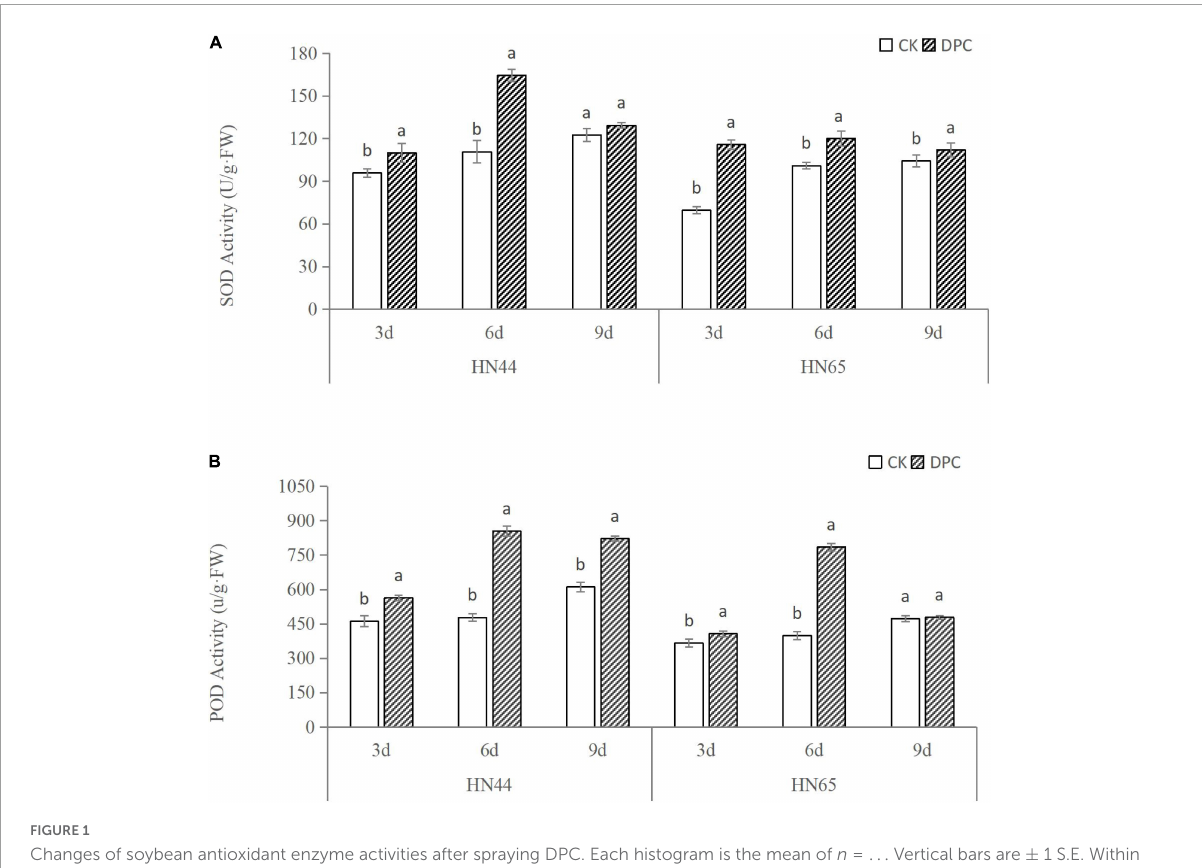
FIGURE1 Changes of soybean antioxidant enzyme activities after spraying DPC. Each histogram is the mean of n = ... Vertical bars are ± 1 S.E. Within each variety, different letters indicate significant differences at P < 0.05.